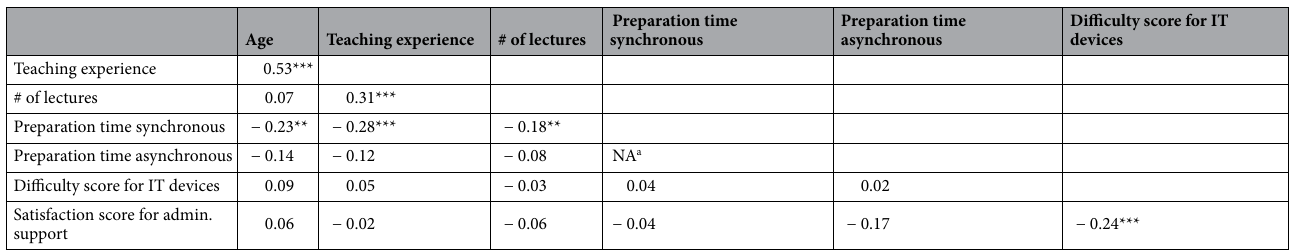
Table 2. Associations among demographic characteristics. ***: p < 0.001, **: p < 0.01, *: p < 0.05. a Not